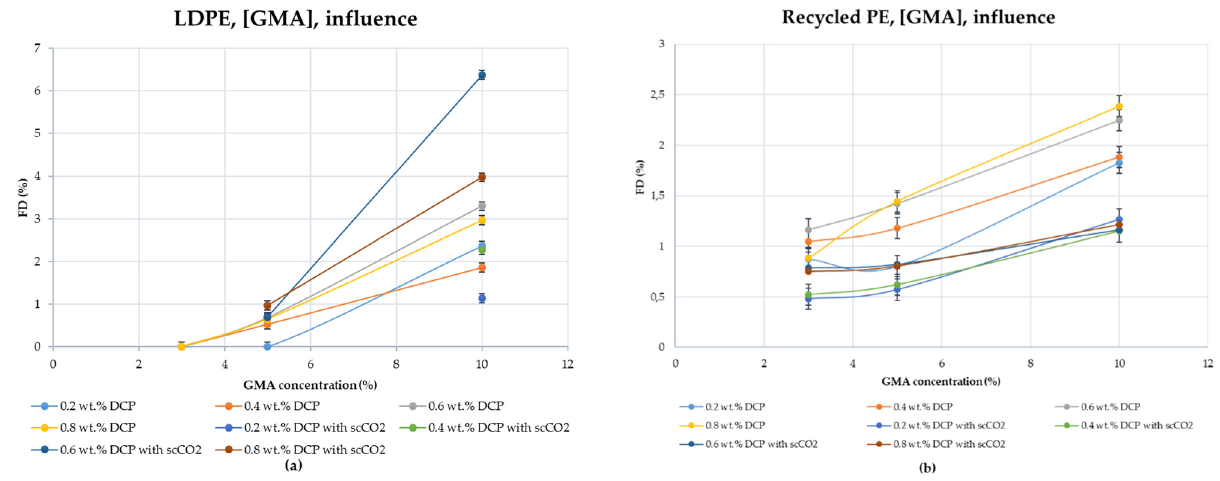
Figure 4. Effect of GMA concentration on the FD for LDPE ( a ) and RPE ( b ).